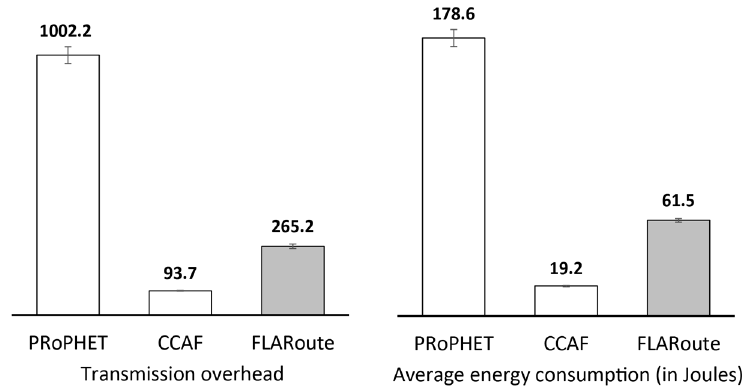
Figure 13. The impact of CCAF and FLARoute on PRoPHET in terms of transmission overhead and average energy consumption. J. Sens. Actuator Netw. 2017 , 6 , x FOR PEER REVIEW